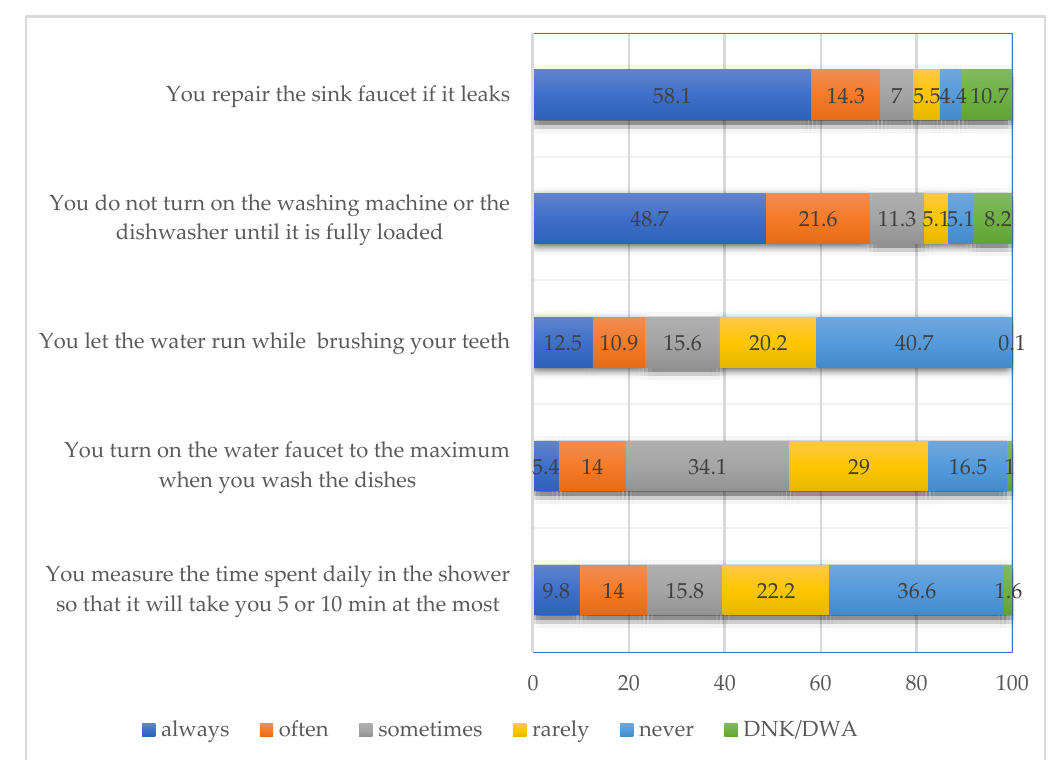
Figure 2. Respondents’ awareness of environmental protection.